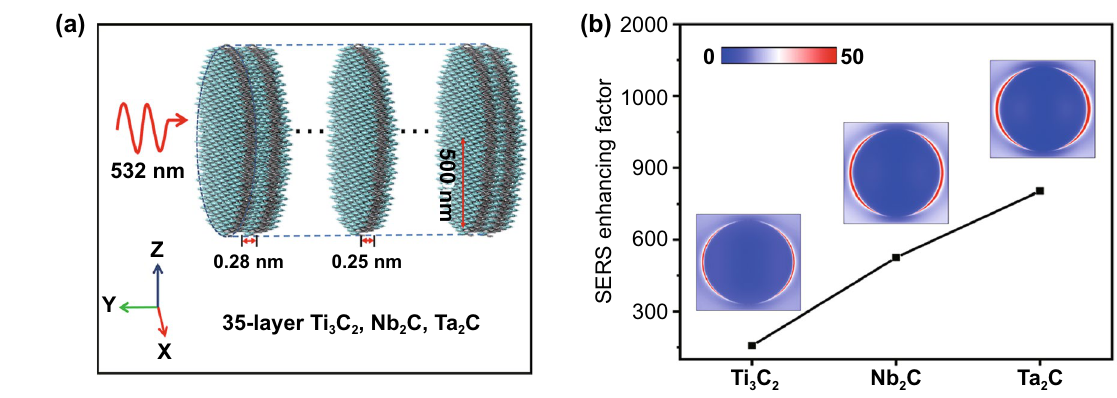
Fig. 2 a Model of MXene (Ti 3 C 2 , Nb 2 C, Ta 2 C) for E-field intensity distribution simulation. b Simulated electric field intensity distribution of MXene (Ti 3 C 2 , Nb 2 C, and Ta 2 C) and corresponding SERS enhancing factor. Color bar represents electric field